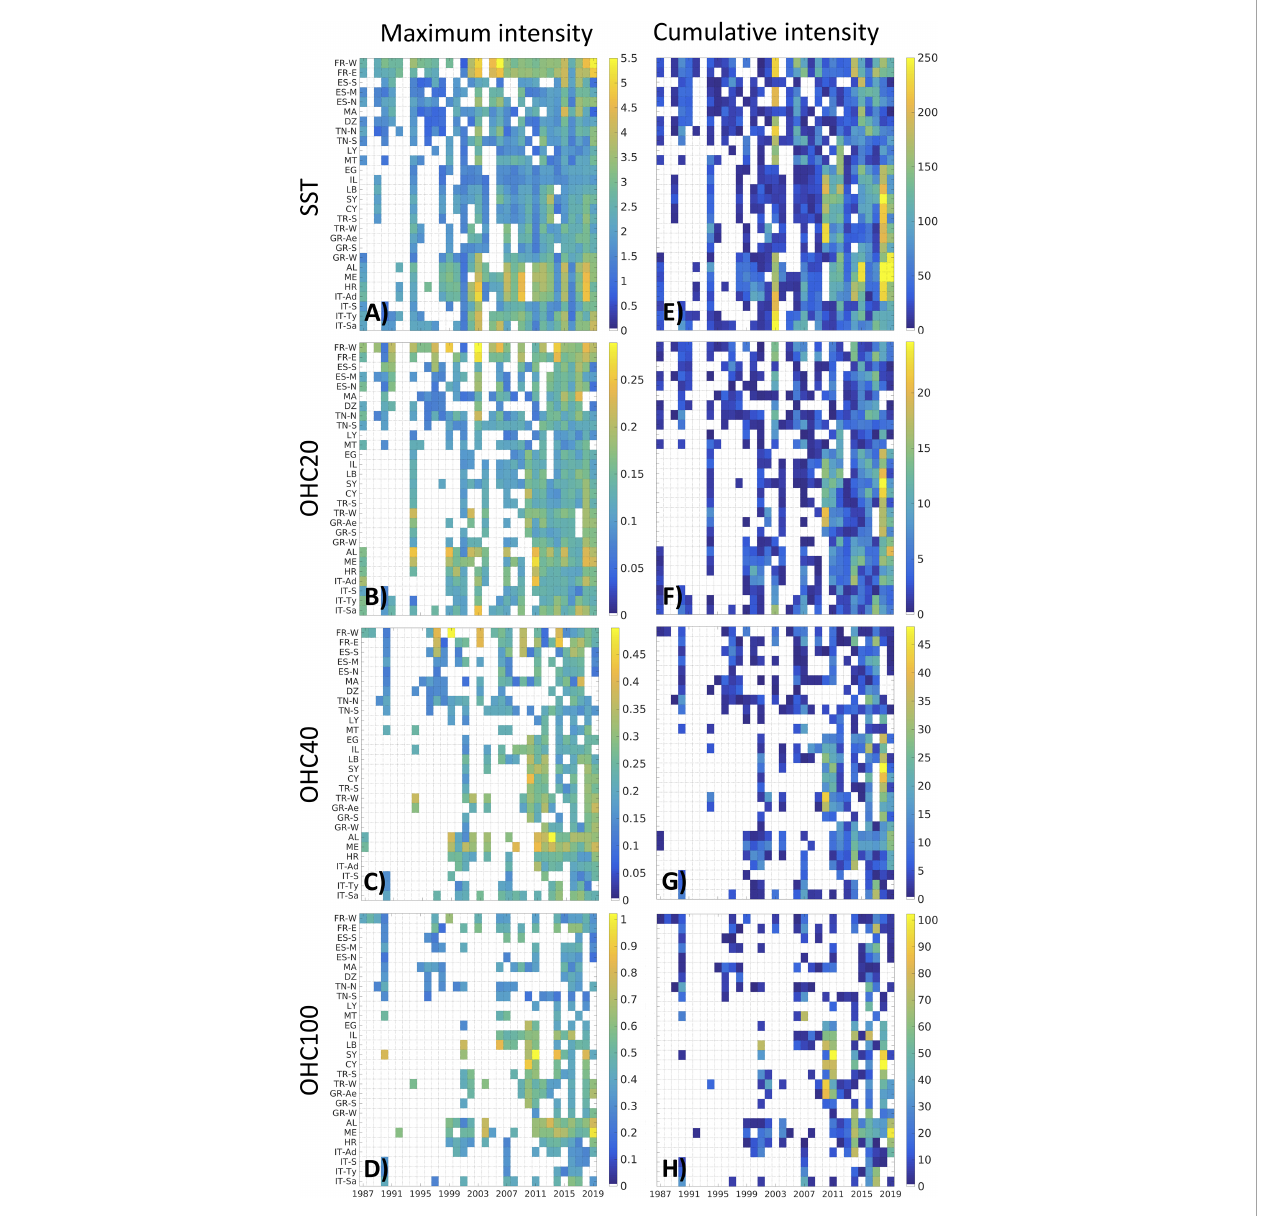
FIGURE 10 Annual means of MHW maximum (A – D) and cumulative (E – H) intensities (in °C for A , E and in GJ/m2 for B – D, F – H ) over the period 1987 – 2019 in the different EEZs, computed from MEDREA SST (A, E) , OHC within [0-20 m] (B, F, J) , OHC within [0-40 m] (C, G) and OHC within [0-100 m] (D, H)